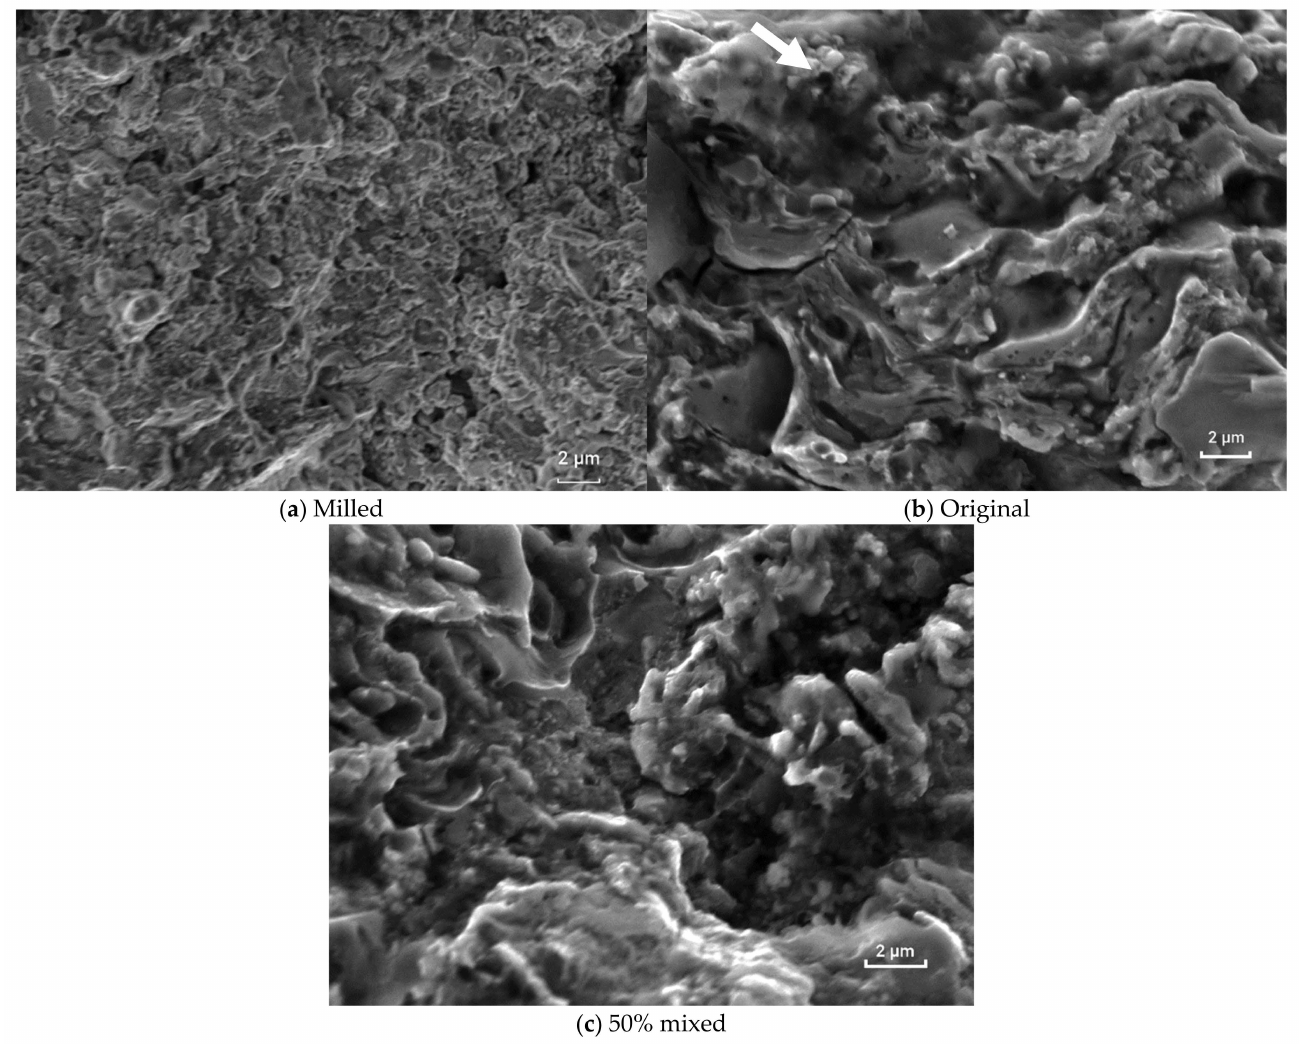
Figure 11. SEM images of the fractured surfaces of the coatings made from ( a ) HEM-milled; ( b ) original—the arrow denotes the outer surface of the specimen; and ( c ) 50% mixed spray powder. Fatigue striations can be seen coming from the coating